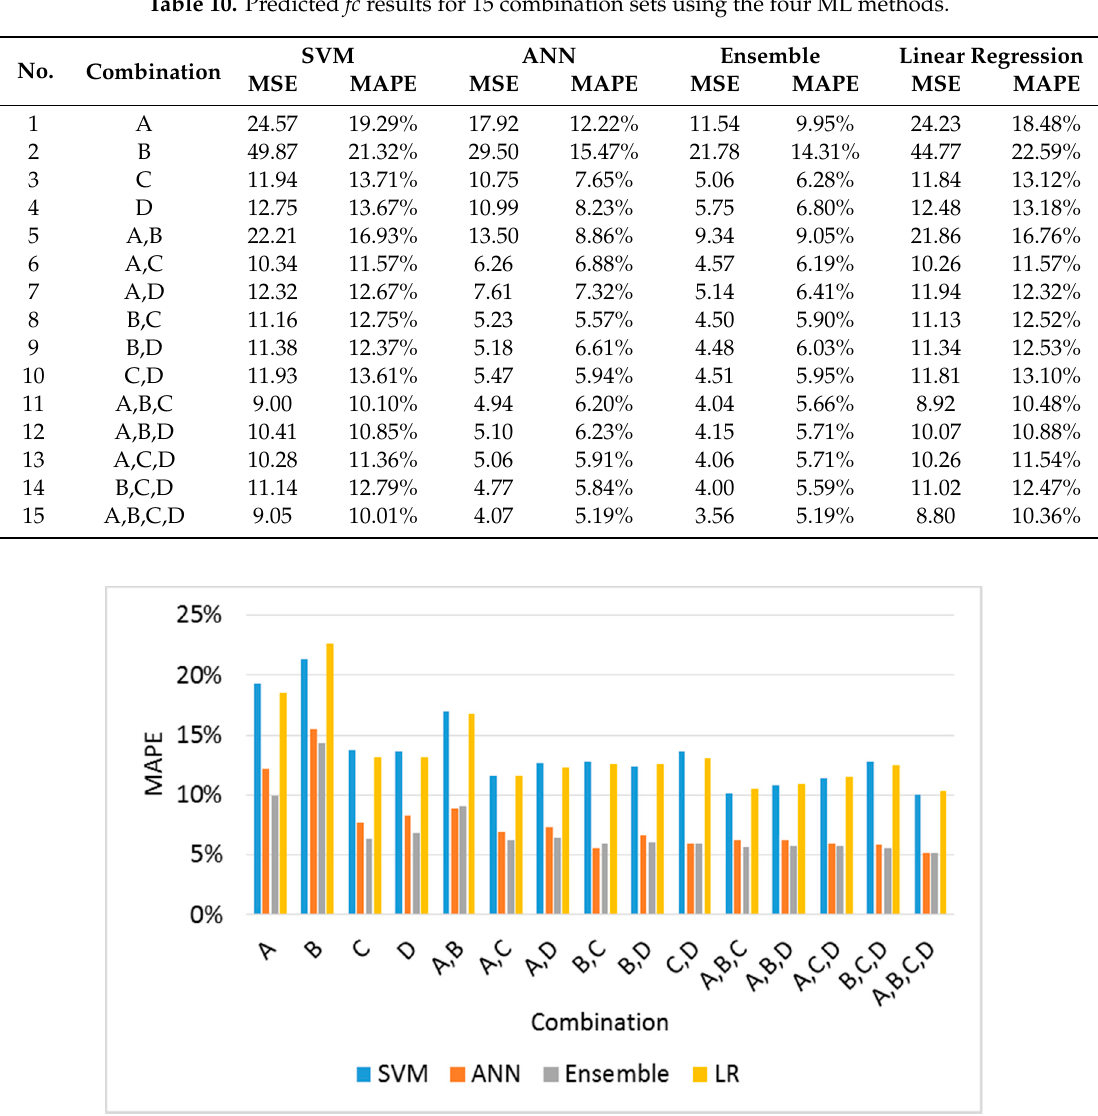
Figure 14. Comparison of MAPE for combinations using four ML methods. Table 10. Predicted fc results for 15 combination sets using the four ML methods.